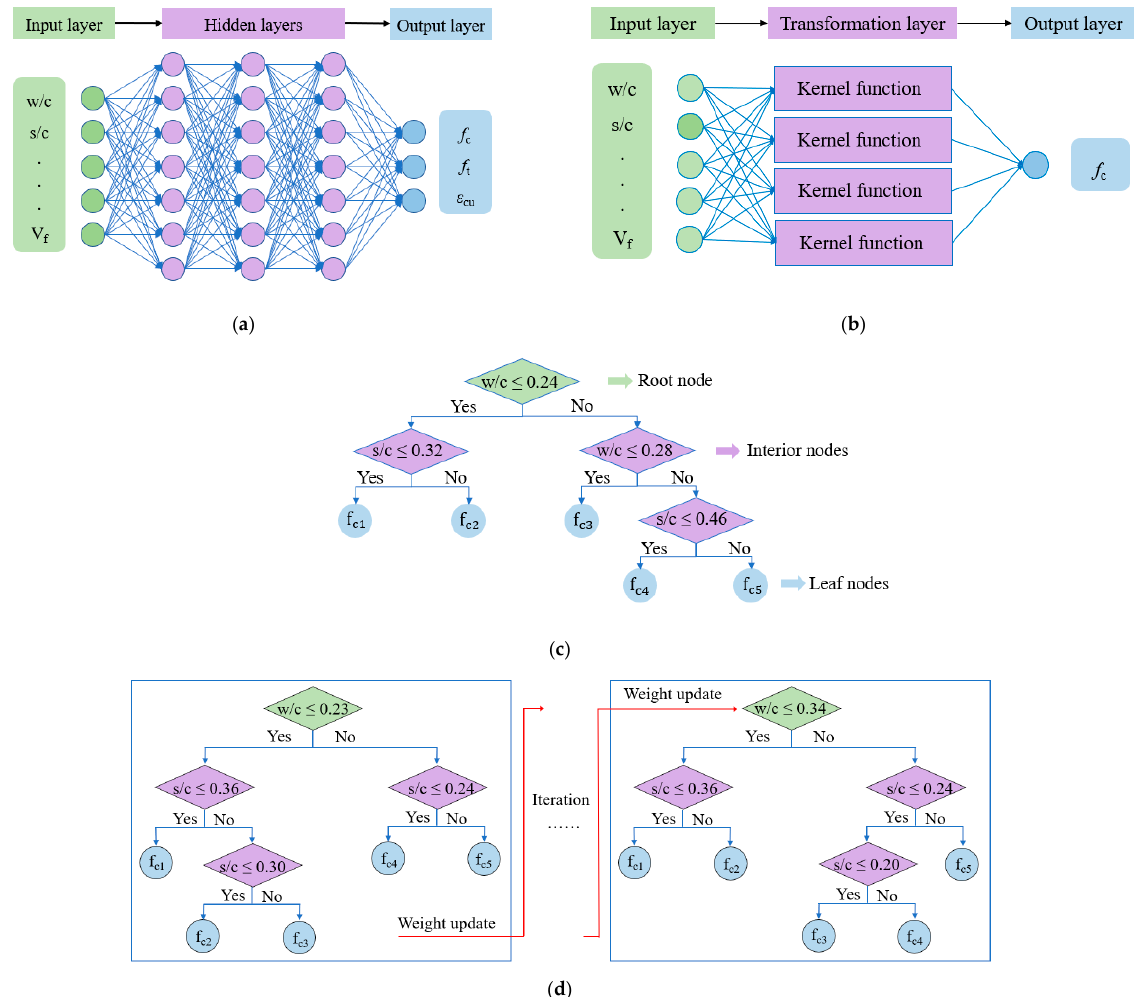
Figure 1. Machine learning models: ( a ) ANN; ( b ) SVR; ( c ) CART; and ( d ) XGBoost. w/c is the water-to-cement ratio; s/c is the sand-to-cement ratio; V f is the fiber content; f c is the compressive strength; f t is the tensile strength; and ε cu is the tensile strain capacity (i.e., ductility).